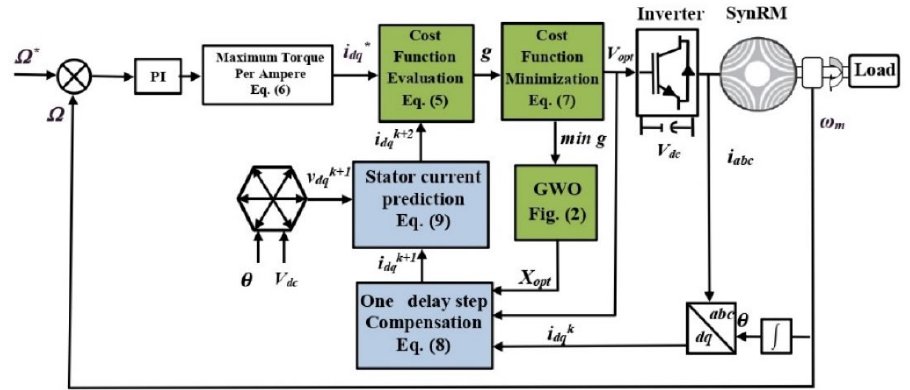
Figure 3. Control Diagram of the SynRM drive system with GW-MFPCC.